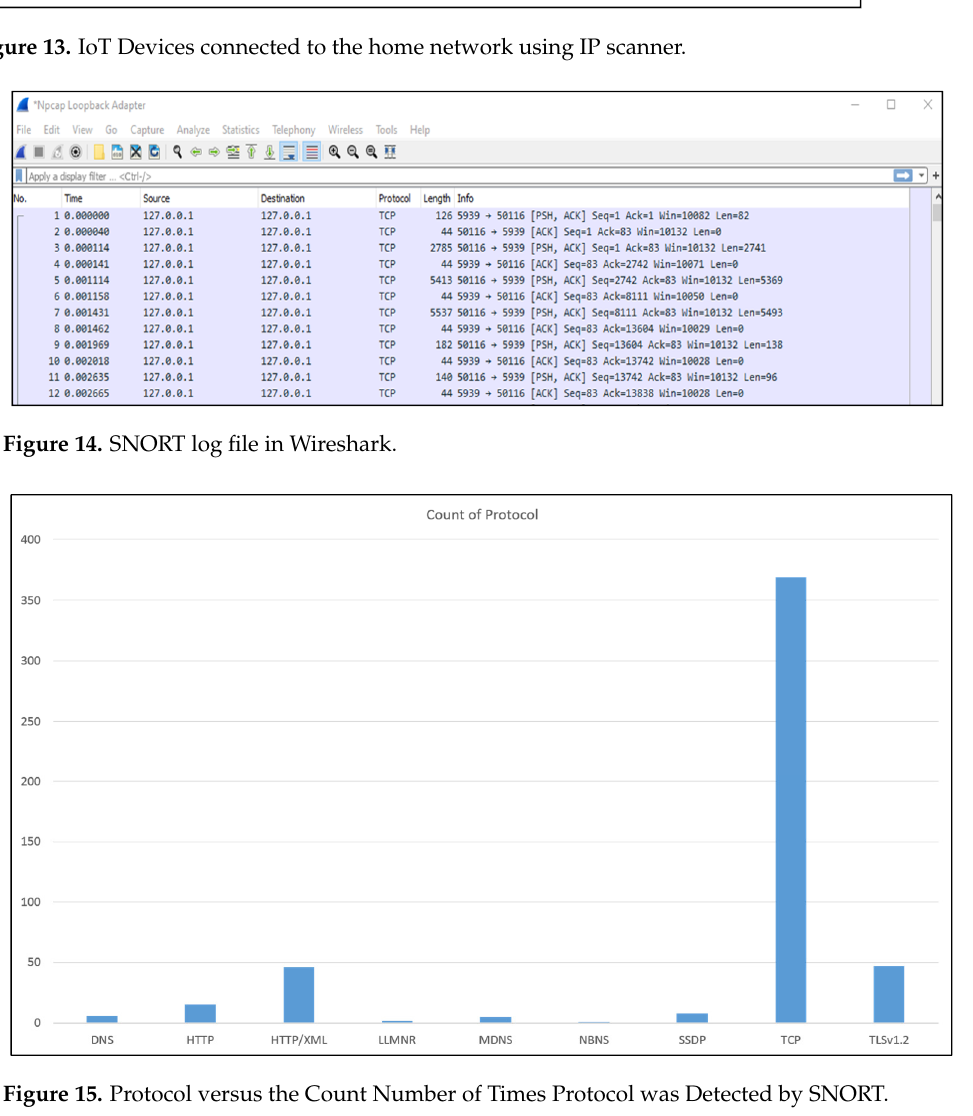
Figure 15. Protocol versus the Count Number of Times Protocol was Detected by SNORT.